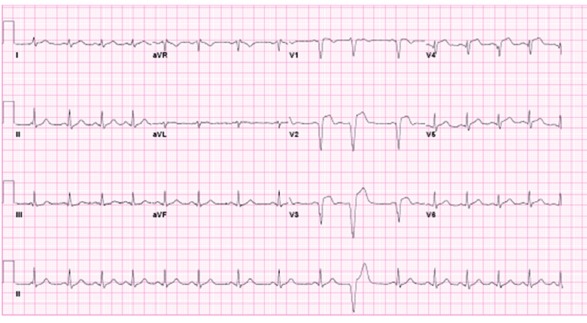
Figure 1: Sinus arrhythmia, with PVC. Anteroseptal infarct.